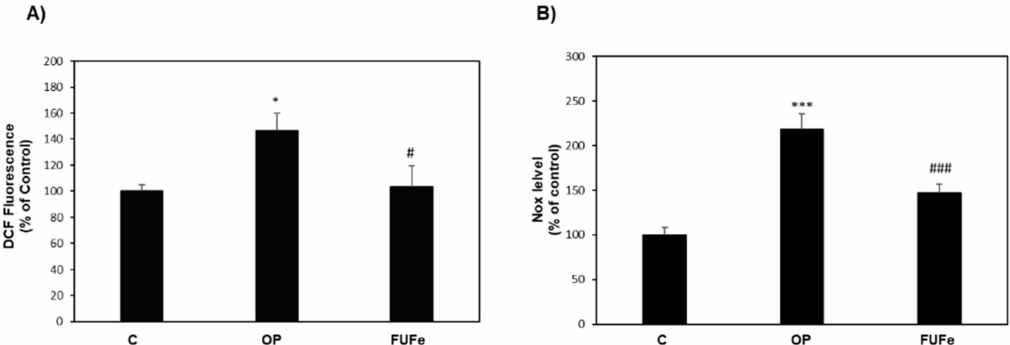
Figure 4. Effects of FUFe in steatotic HECV cells. ( A ) DCF fluorescence and ( B ) NOx production were quantified in control (C) and steatotic cells incubated in the absence (OP) or in the presence of 50 µ g/mL FUFe for 24 h. Data are expressed as percentage relative to control. Values are mean ± S.D. from three independent experiments. Significant differences are denoted by symbols: * p ≤ 0.05, *** p ≤ 0.001 vs. C; # p ≤ 0.05, ### p ≤ 0.001 vs.